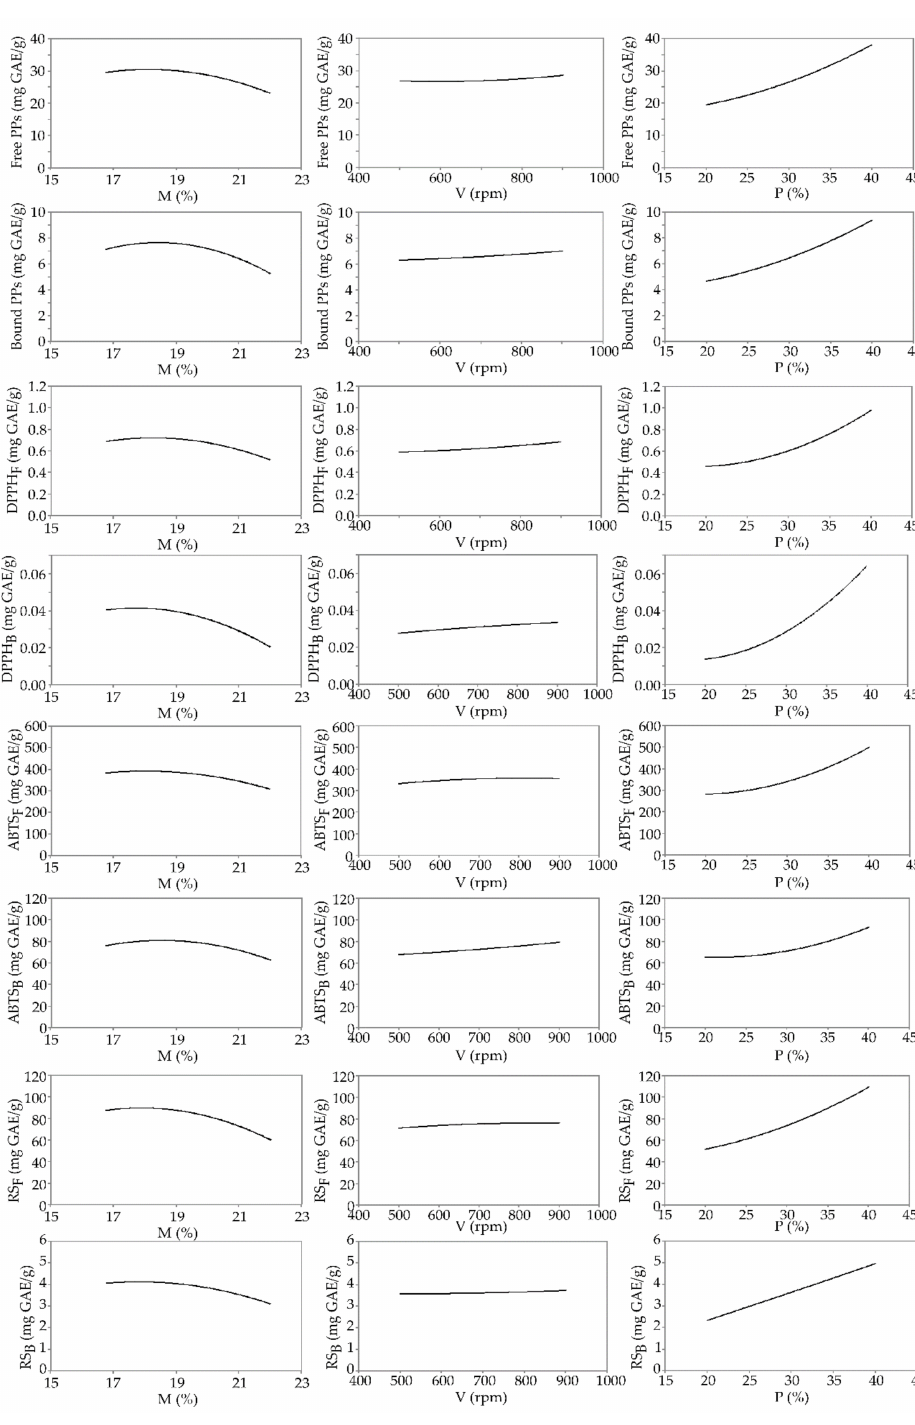
Figure 3. Influence of extrusion conditions (M—moisture content; V—screw speed; P—chicory root content) on polyphenols (PPs) content and antioxidative activity. Index F represent fraction of free polyphenols, and index B represents fraction of bound